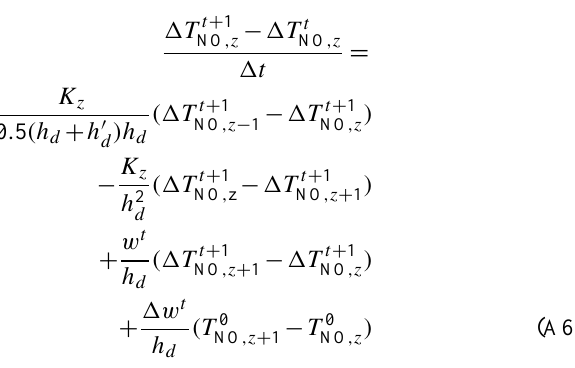
Fig. A2. The schematic oceanic area and initial temperature profiles in MAGICC’s ocean hemispheres. Diffusion driven heat transport is modeled proportional to the vertical gradient of temperature, which is especially high below the mixed